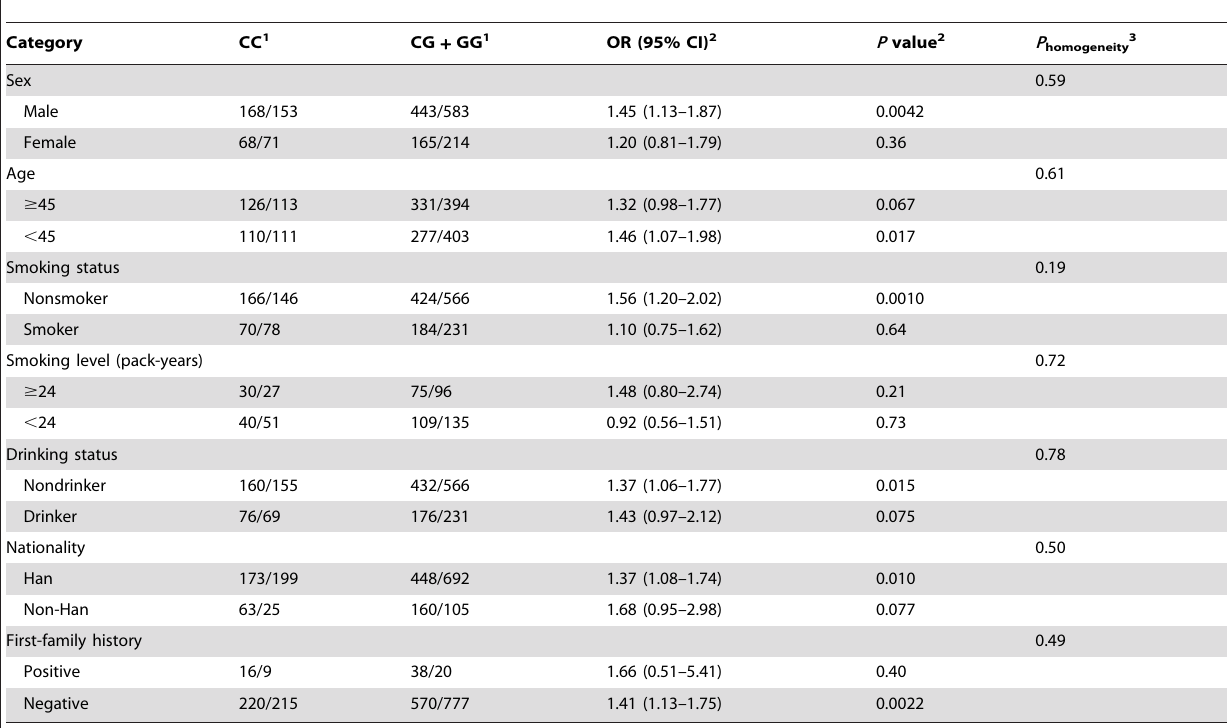
Table 2. Risk of NPC associated with the BIRC5 -31C/G polymorphism by potential risk factors in the Guangxi